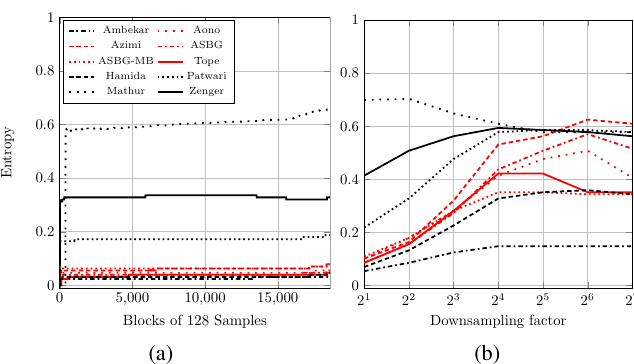
Figure 8: Evaluation results based on the real-world setups 1 − 12 of all quantization schemes for (a) estimated min- entropy over time (b) on-line entropy estimation for different downsampling